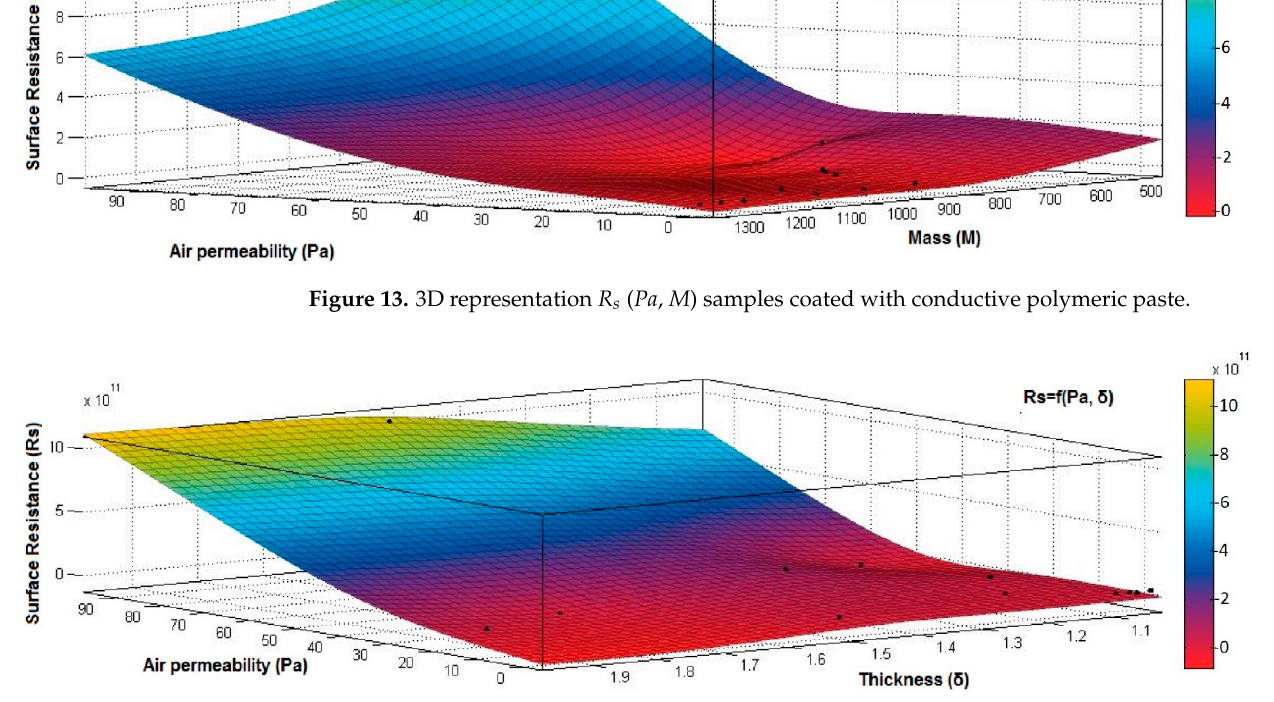
Figure 14. 3D representation Rs = f( Pa , δ ) samples coated with conductive polymeric paste.